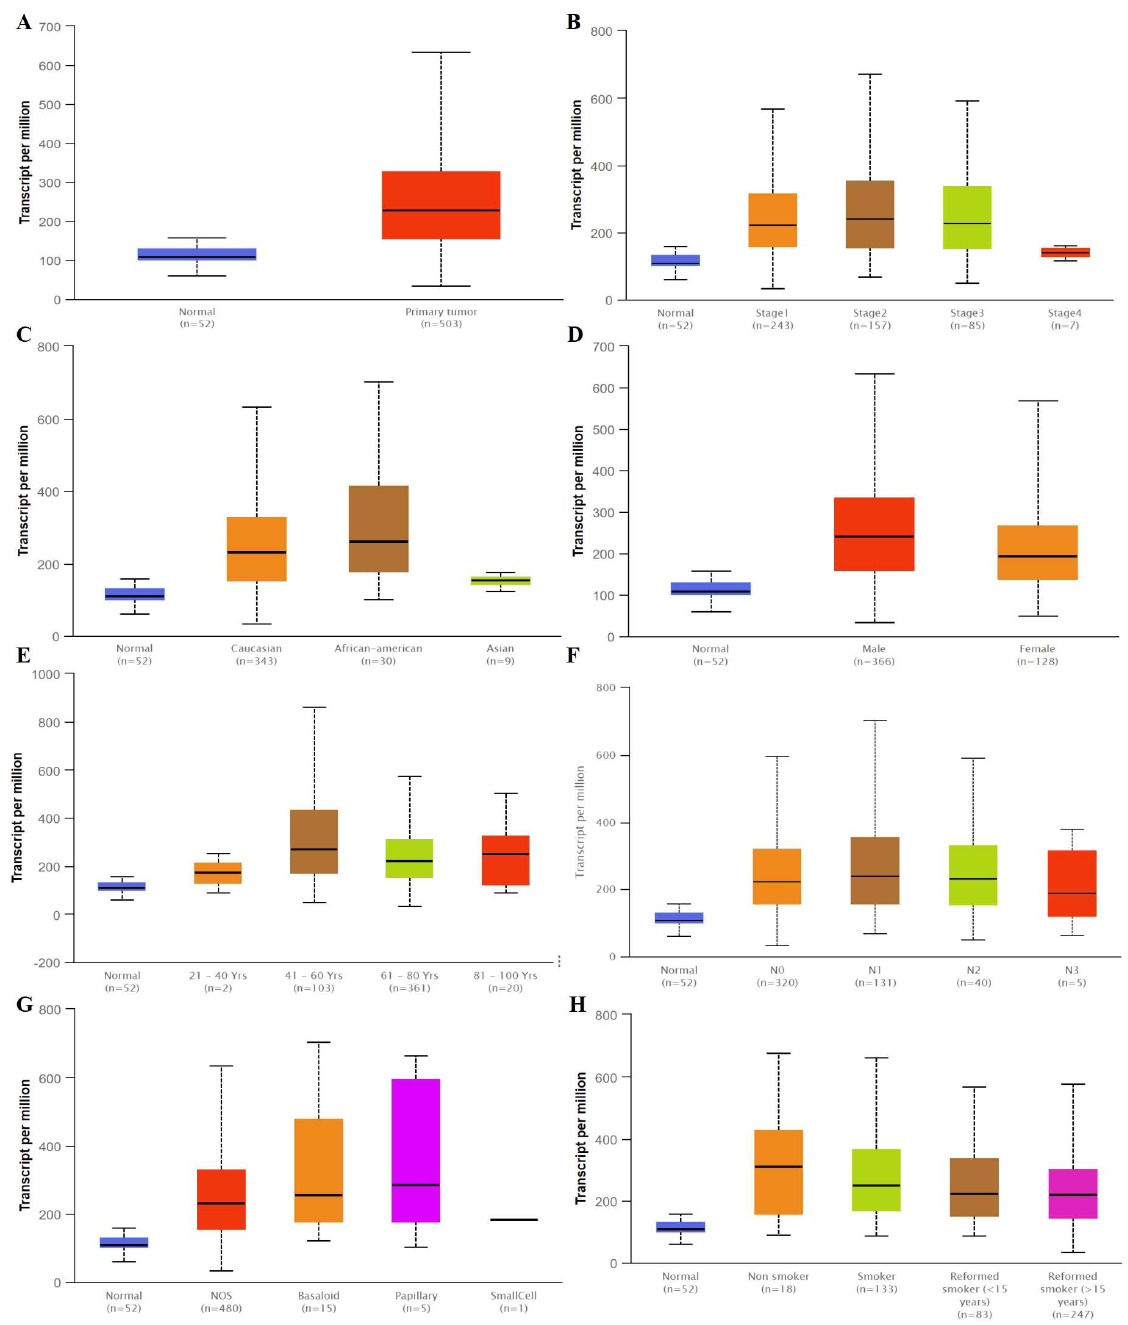
Figure 2. The mRNA level of SLC3A2 expressed in tumor tissues and in matched normal tissues from different subgroups of LUSC patients. ( A ) Sample type; ( B ) Stages; ( C ) Race; ( D ) Gender; ( E ) Age; ( F ) Nodel metastasis; ( G ) Tumor histology; ( H ) Smoking habits.